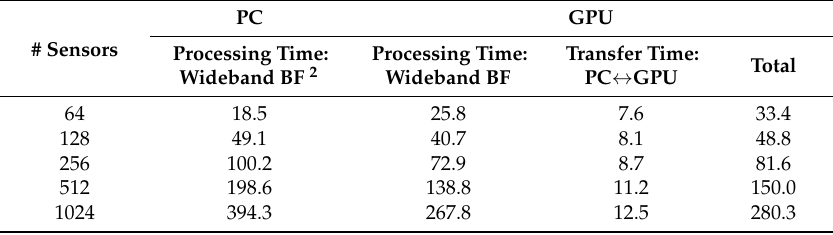
Table 4. Processing and transfer times 1 vs. number of sensors in the